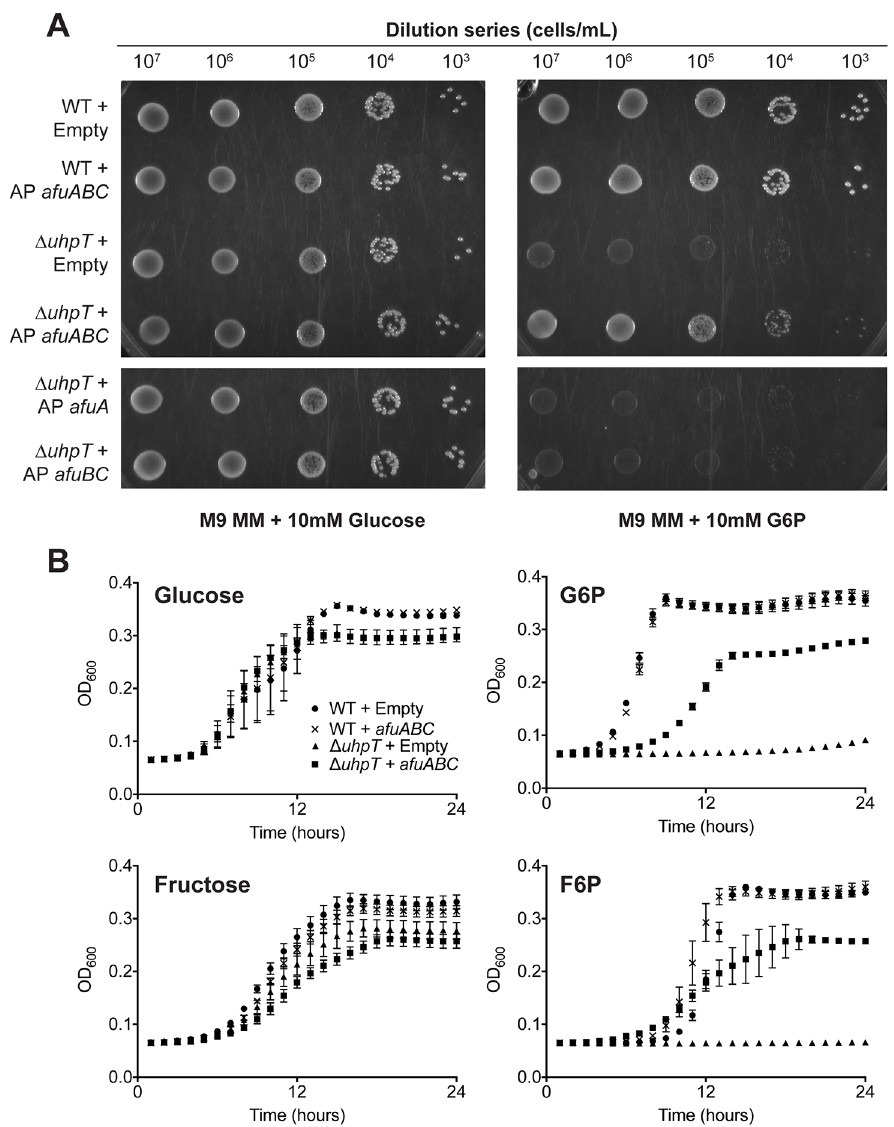
readings for clarity. Curve legend is the same in all panels and is indicated in the first panel. Error bars represent SEM of cell growth from n = 3